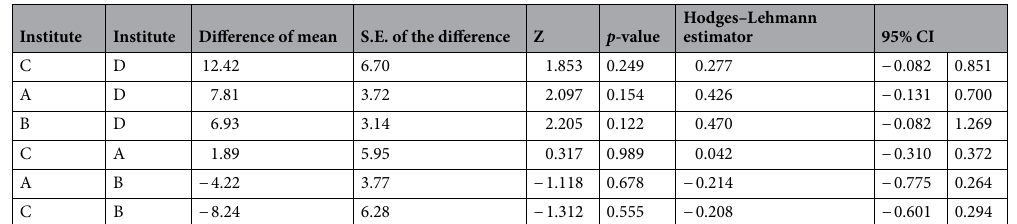
Table 2. Differences in the 5 min FIs of cancer samples among the four institutes. S.E., standard error; Z, Z-value of Steel–Dwass test; CI, confidence interval; FI, fluorescence increase.